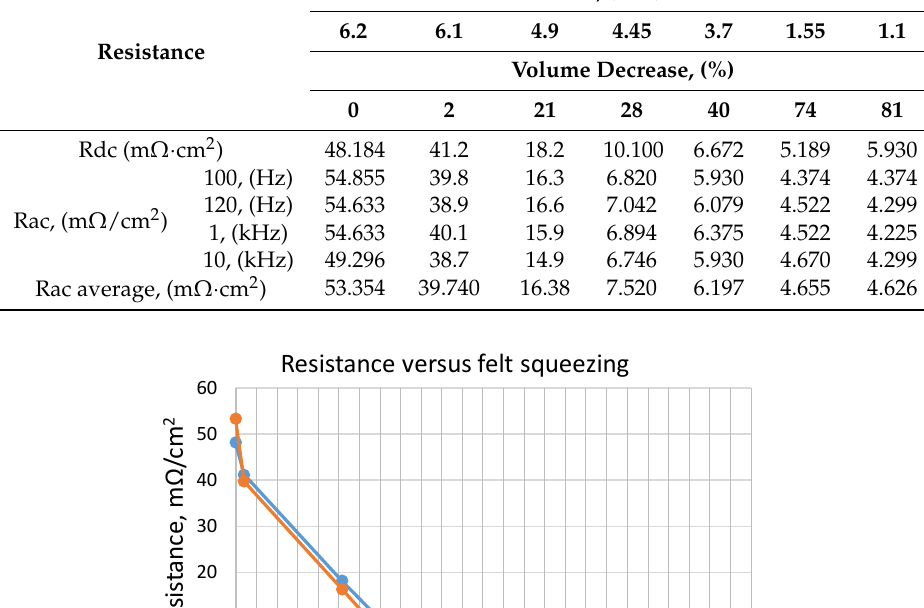
Table 3. Resistance of dry CF.